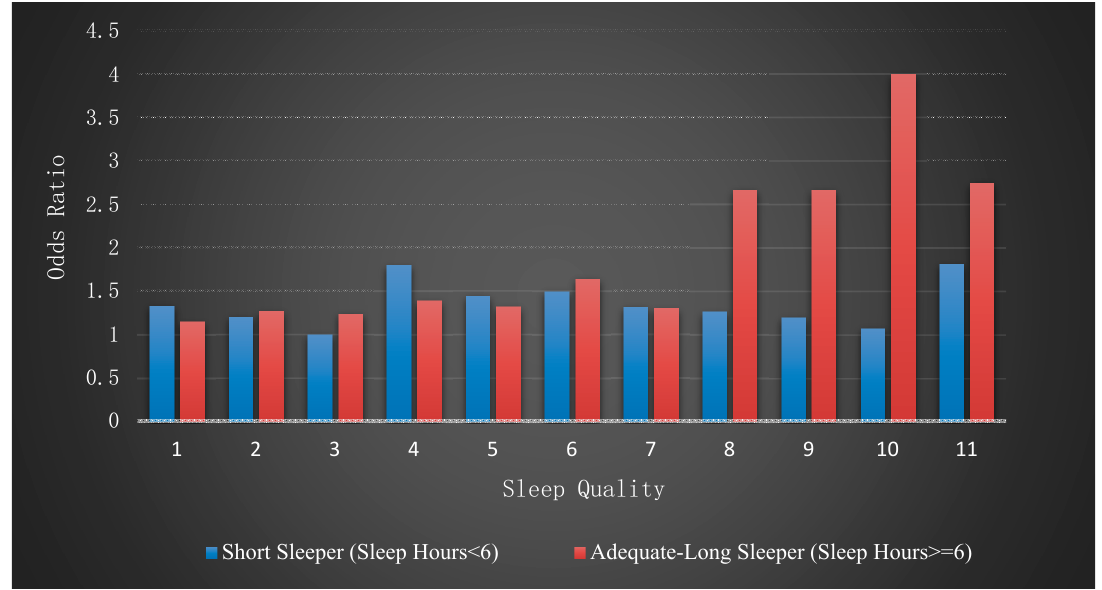
Figure 3. Comparison of odds ratio of risk of MetS with sleep quality for the short sleeper and adequate-long sleeper groups.